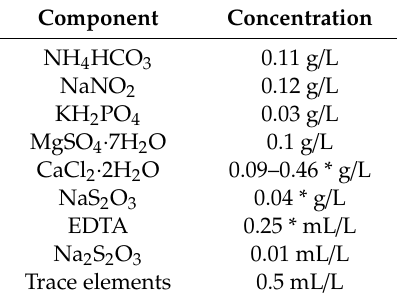
Table 1. Components of the influent.